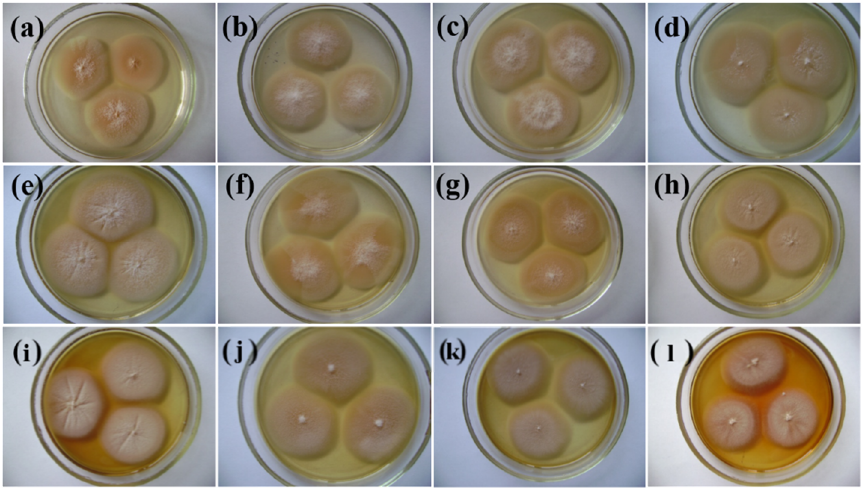
Figure 3. P. melonis 502 colonies on BMA with different pH values: 6.0 ( a ), 6.5 ( b ), 7.0 ( c ), 7.5 ( d ), 8.0 ( e ), 8.5 ( f ), 9.0 ( g ), 9.5 ( h ), 10.0 ( i ), 10.5 ( j ), 11.0 ( k ) and 11.5 ( l ).